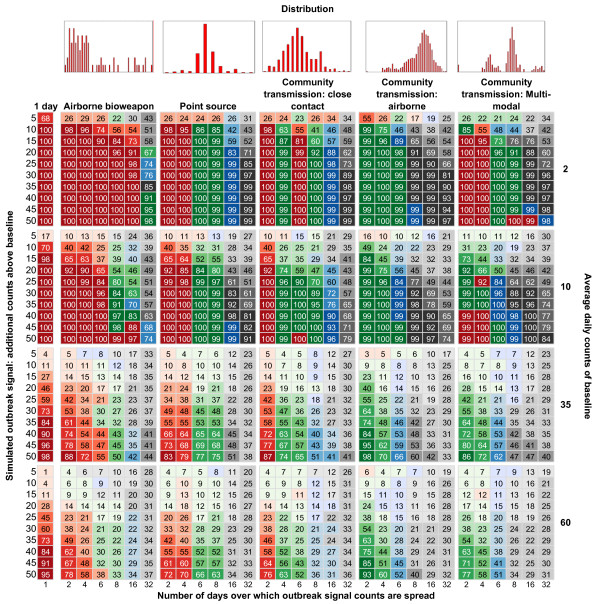
Percent of outbreak signals detected, and median timeliness of detection, for the generalized linear model running at an alert rate of 0.01, for each of 310 outbreak signals on each of four baseline syndromes.